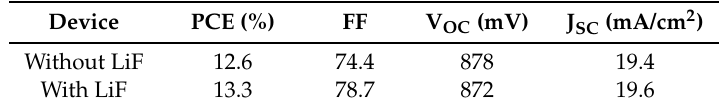
Figure 6. The best solar cell performance without hysteresis behavior (scan rate 0.1 V/s). Table 4. The best perovskite solar cell performance after full optimization. Scan direction